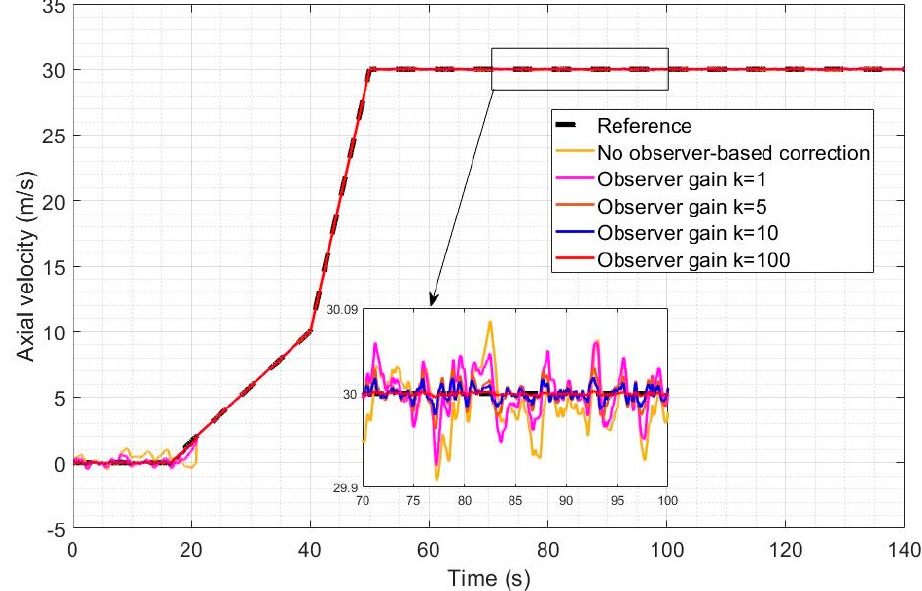
Figure 7. Axial speed reference tracking under a high wind intensity for different values of the perturbation observer gain.